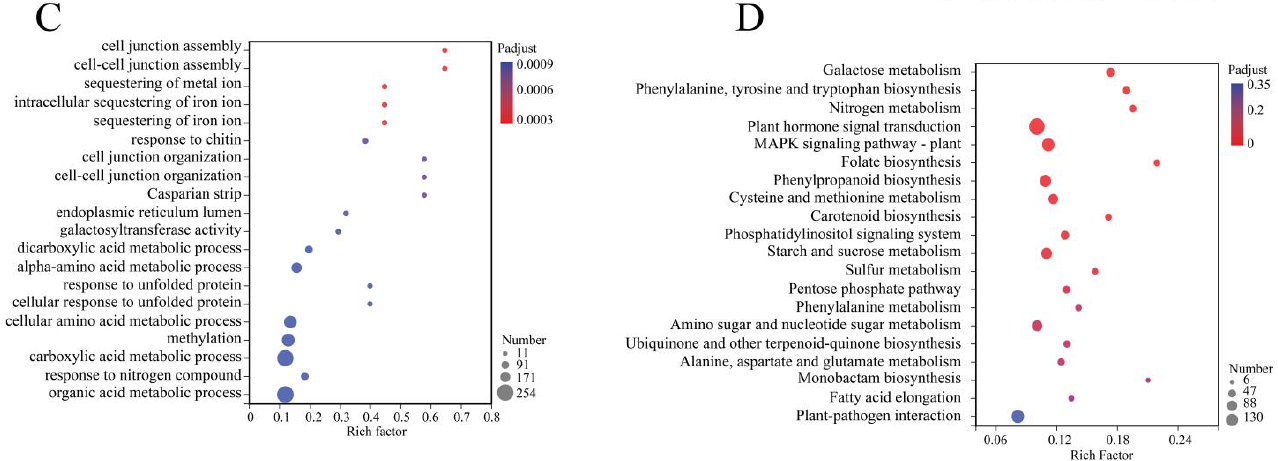
Figure 3. WGCNA analysis of specifically expressed genes in L96. ( A ) Co-expression network modules are enriched. Each module is given a different color. ( B ) Module–sample relationships. Each row corresponds to a color module and each column corresponds to a sample. ( C ) GO enrichment of L96-specific expressed genes. ( D ) KEGG enrichment of L96-specific expressed genes.